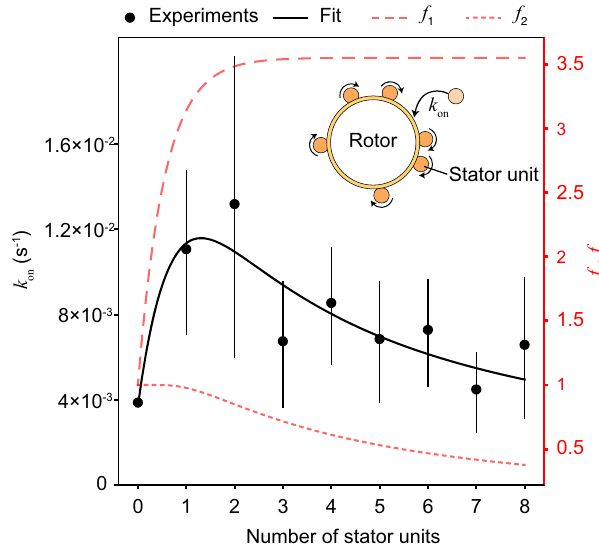
Fig. 4 | Binding kinetics depend onthenumber ofpreviously bound units. The binding rate k on for an individual stator unit at different numbers of bound stator units ( N ).The black curve was obtained from the simple model k on ( N )= k on (0) f 1 ( N ) f 2 ( N ),where k on (0)=0.0037s − 1 is the on rate for N =0and the two functions, f 1 and f 2 , are given by f 1 ð N Þ = ð 1+ A ð 1 (cid:2) exp (cid:2) BN ½ (cid:3)ÞÞ and f 2 ð N Þ =1 (cid:2) exp (cid:2) C = N meters A , B , and C are determined from fi tting the experimental data: A =0.23, B =1.8, C =3.8.Thedatapresentedaremeansandtheerrorbarsrepresentstandard deviation. The sample size for 0,1, 2,...8 stator unitsis74,63, 75, 70, 77, 81, 80, 83, and 74,